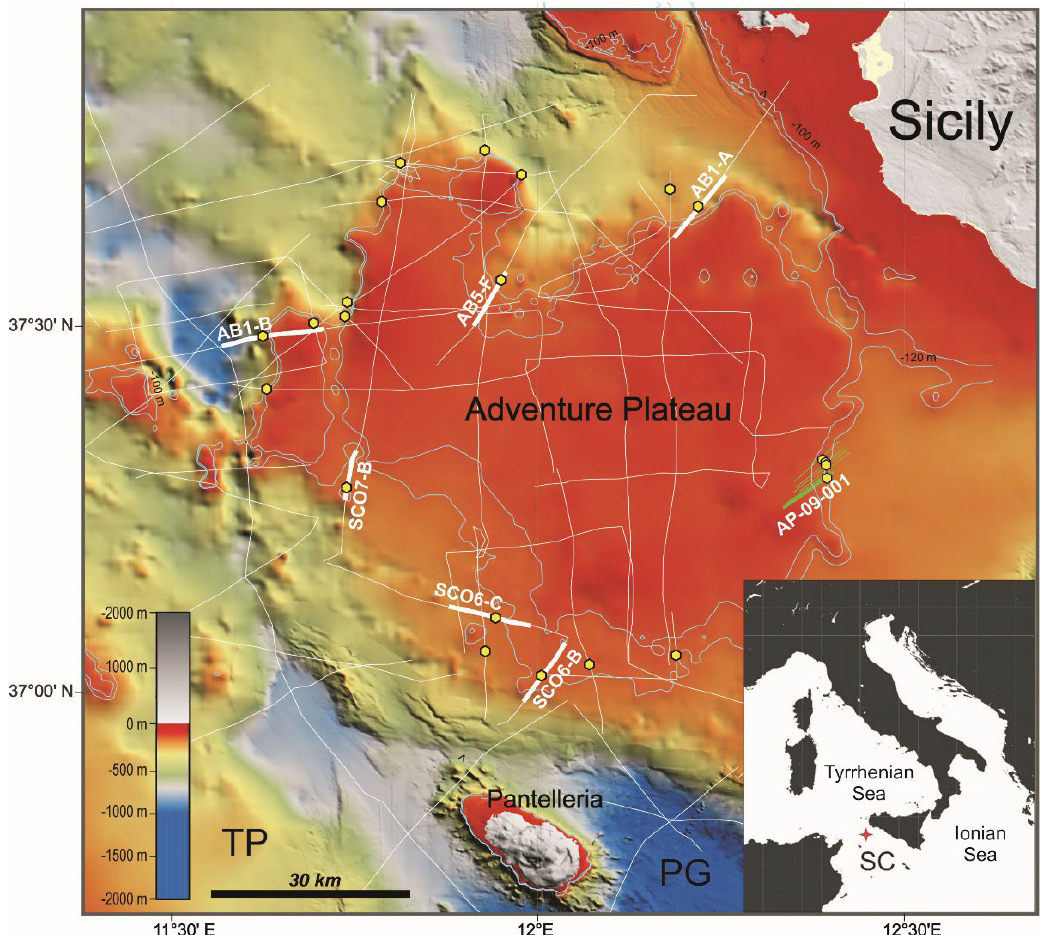
Figure 1. General morpho-bathymetric map of the northwestern Sicilian Channel. Background bathymetry taken from http://www.emodnet-bathymetry.eu/ (accessed on 7 December 2018), on which recently acquired multibeam swaths have been superimposed. The digital elevation model (DEM) for land areas has been produced by gridding the SRTM90 data (http://www.cgiar-csi.org/) (accessed on 1 July 2013). Bathymetry contours of − 100 and − 120 m water depths are shown (light blue lines). Yellow dots indicate the locations where the palaeo-shoreline at the LGM has been identified from high-resolution geophysical profiles. Thick white segments refer to the corresponding sparker profiles presented in Figure 3. Green segment refers to the chirp profile presented in Figure 3. Box at the lower right corner shows the location of the study area (red star). TP: Tunisian Plateau; PG: Pantelleria graben; SC: Sicilian Channel.